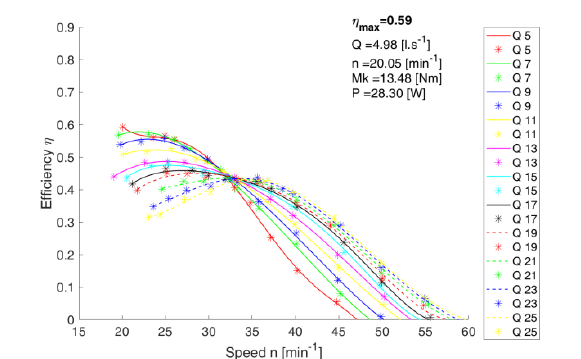
Fig. 7. Efficiency for configuration, bucket -20 and channel edge position -80 for different flow rates.